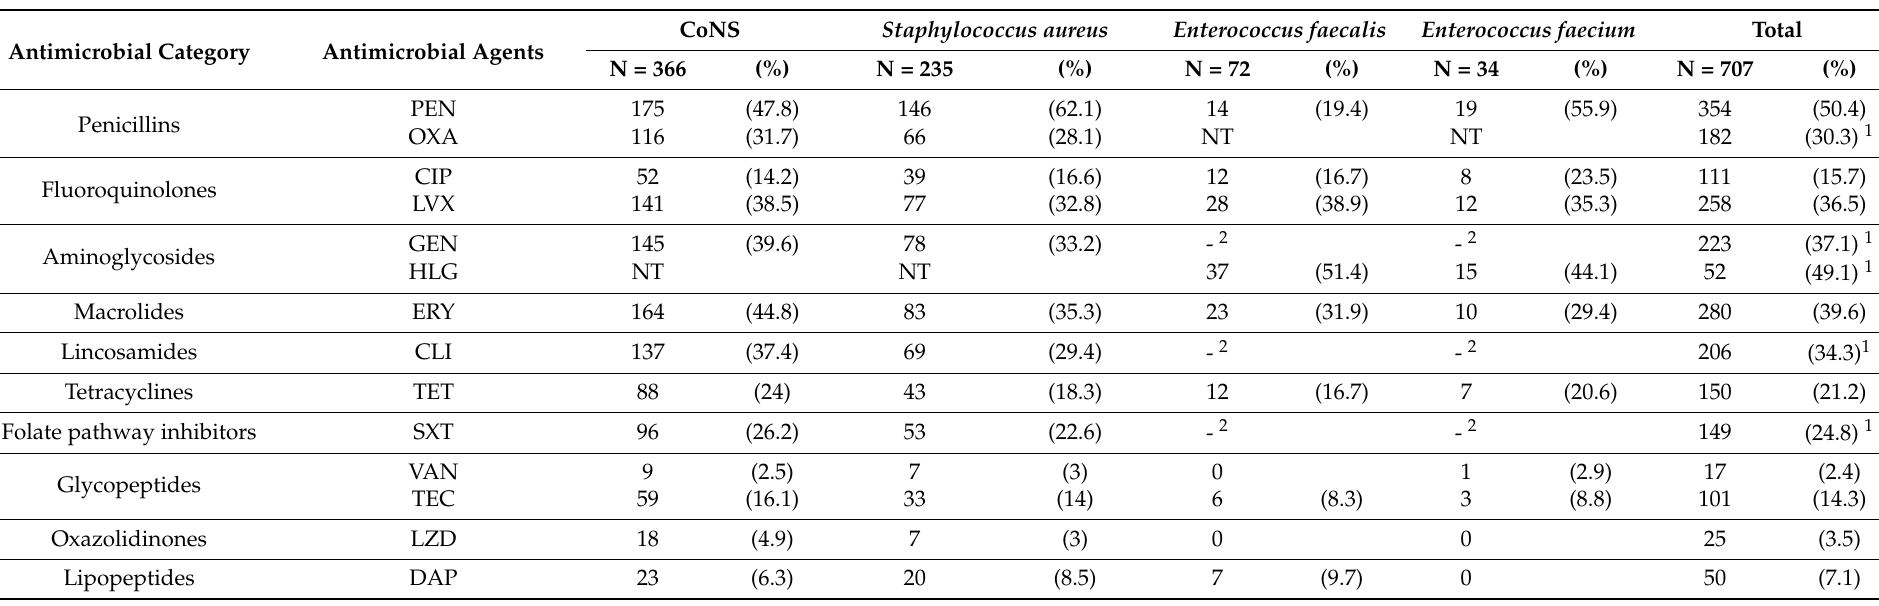
Table 1. Distribution of antimicrobial resistant phenotype among Gram-positive organisms by bacterial species and tested antimicrobial agents. Antimicrobial Category Antimicrobial Agents